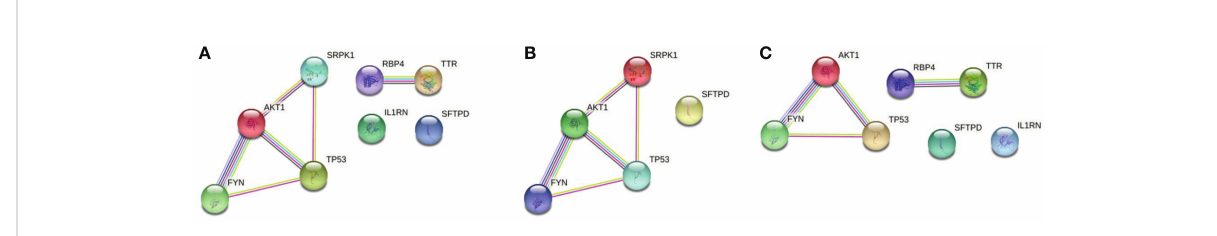
FIGURE 3 (A) PPI network of 8 potential targets. (B) PPI network of the SARS-CoV-2 speci fi c targets. (C) PPI network of the in fl ammatory targets. Associations are meant to be speci fi c and meaningful, i.e. proteins jointly contribute to a shared function; this does not necessarily mean they are physically binding to each other. The light-blue edges denote known interactions from curated databases. The pink edges show that the known interactions were determined by experimental methods. The yellow edges demonstrate that the predicted interactions arose from text- mining. The black edges denote that the predicted interactions arose from co-expression. The lavender edges show that the predicted interactions arose from protein homology. The dark-blue edges denote that the predicted interactions arose from gene co-occurrence.